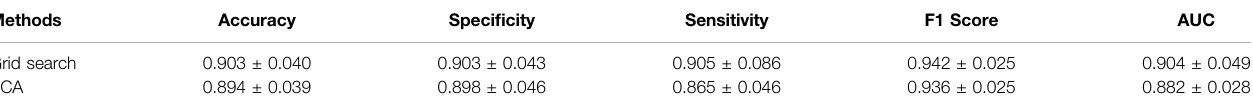
TABLE 7 | Comparison of the classi fi cation effects of two different feature selection methods for the VCG + ECG model